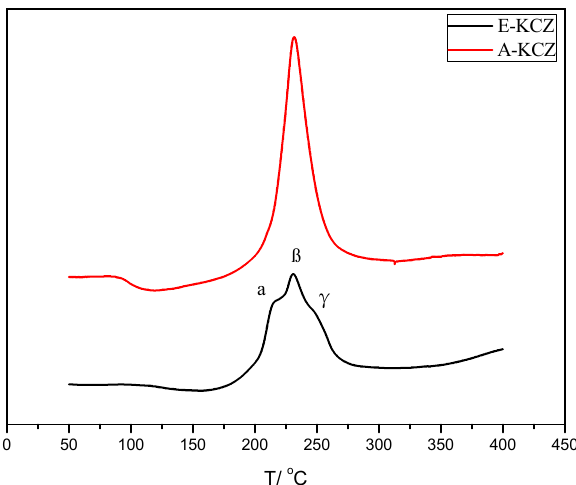
Figure 3. H 2 -TPR profiles of ZrO 2 -based catalysts.